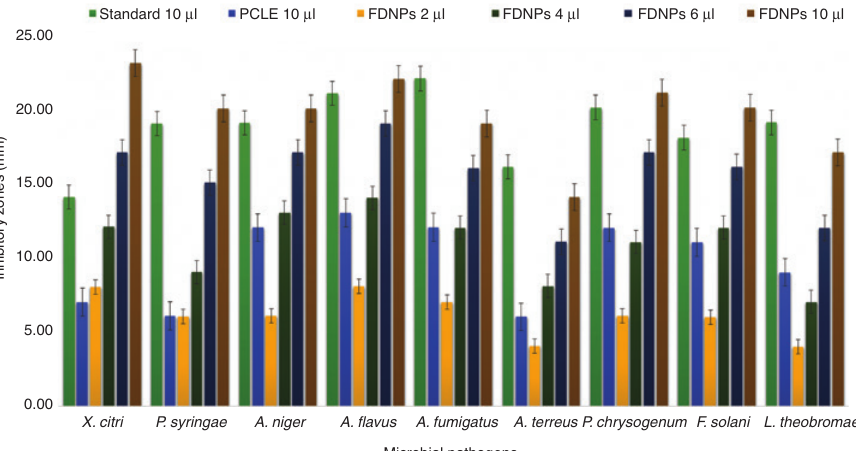
Figure 8: In vitro biocidal activity of foliar doped nanoparticles against pathogenic strains exhibiting multidrug resistance (standard for bacterial strains ampicillin and standard for fungal strains amphotericin